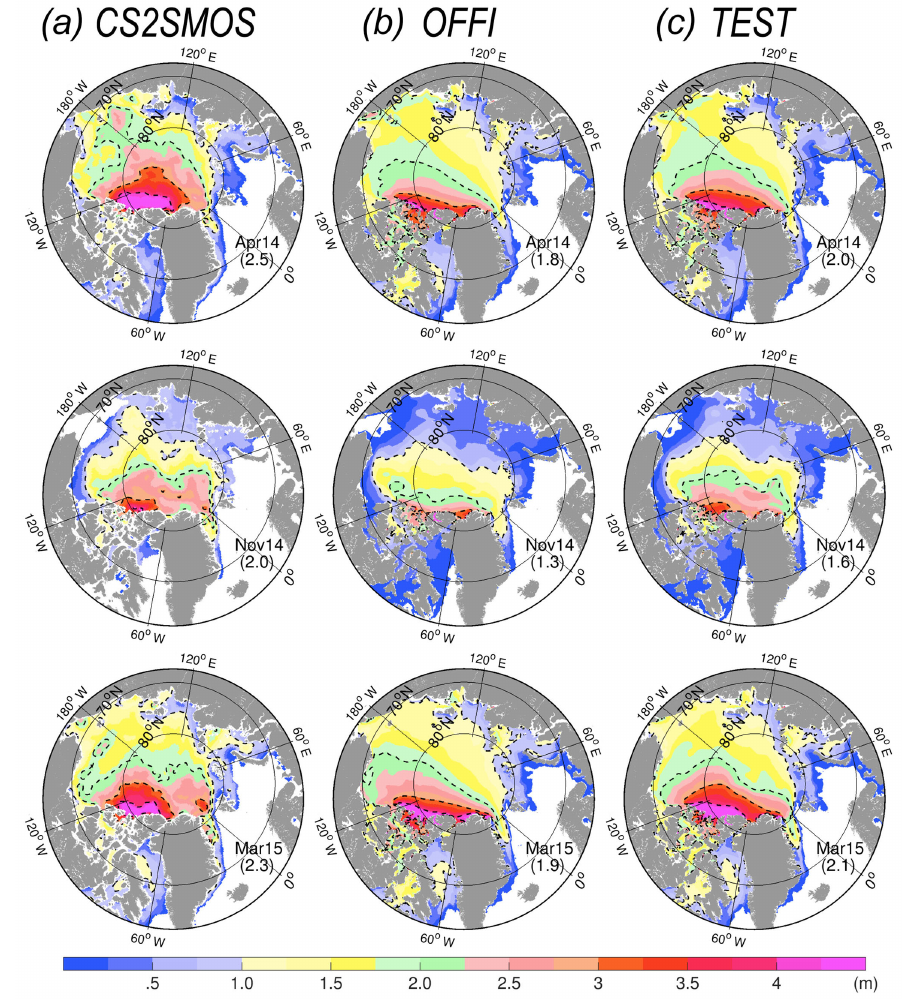
Figure 3. Monthly SIT from CS2SMOS, column (a) , Official run, column (b) , and Test run, column (c) in April 2014, November 2014, and March 2015, respectively. The mean SIT estimated for the area north of 80 ◦ N is indicated between parentheses (unit: m). The dashed lines are isolines of 1, 2, 3 and 4m SIT,